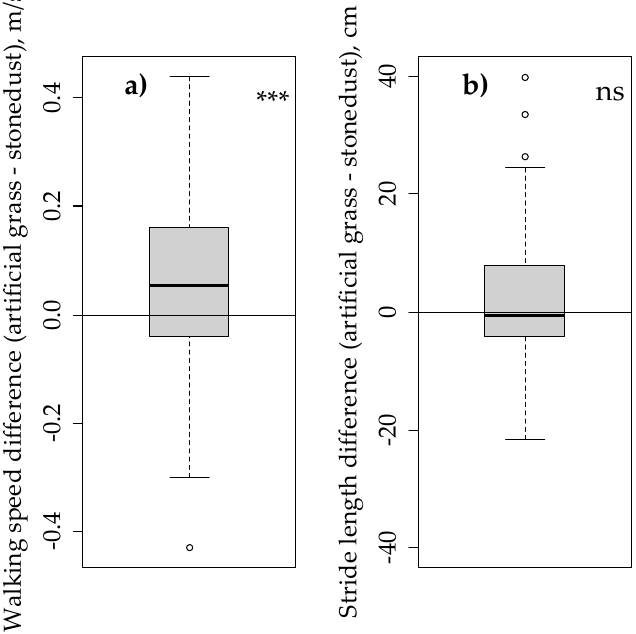
Figure 3. Difference in dairy cow walking behaviour on artificial grass and a standard surface (stone dust-over-gravel), based on 69 pairs of observations. ( a ) Difference in walking speed; ( b ) difference in stride length. *** Significant difference between surface types ( p = 0.001), ns: No significant difference between surface types ( p > 0.10).